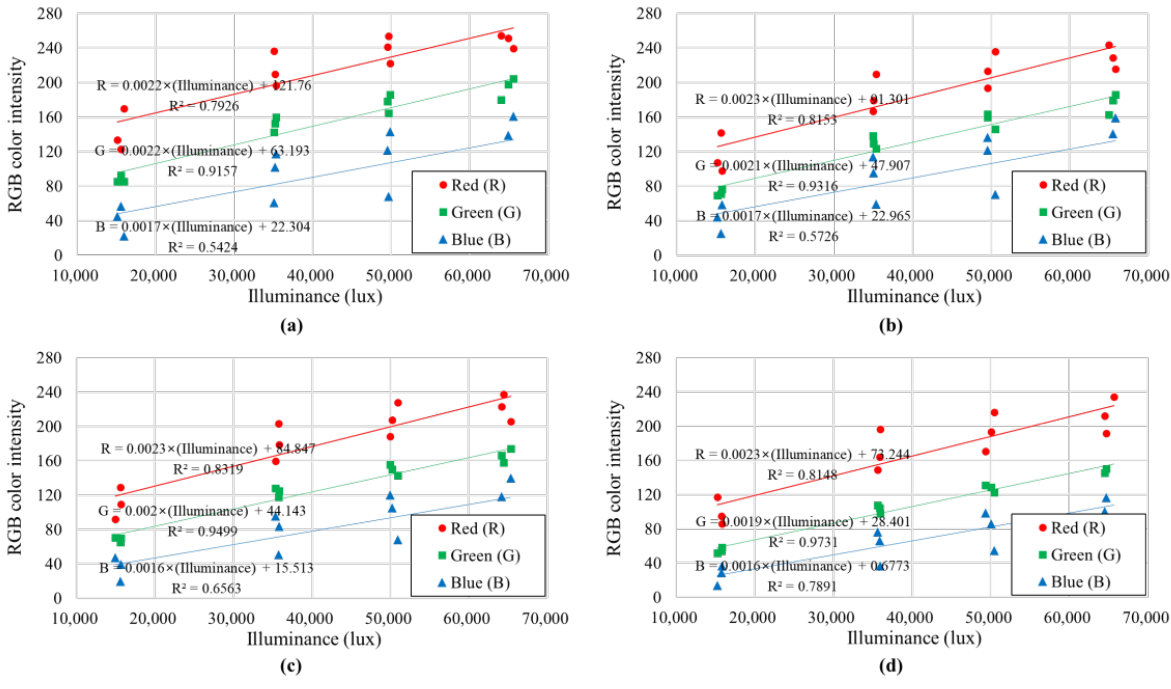
Figure 8. Mode RGB color intensities according to the illuminance of light: ( a ) Jumunjin sand, ( b ) Anseong soil, ( c ) Yongin soil, and ( d ) Gwanak soil.